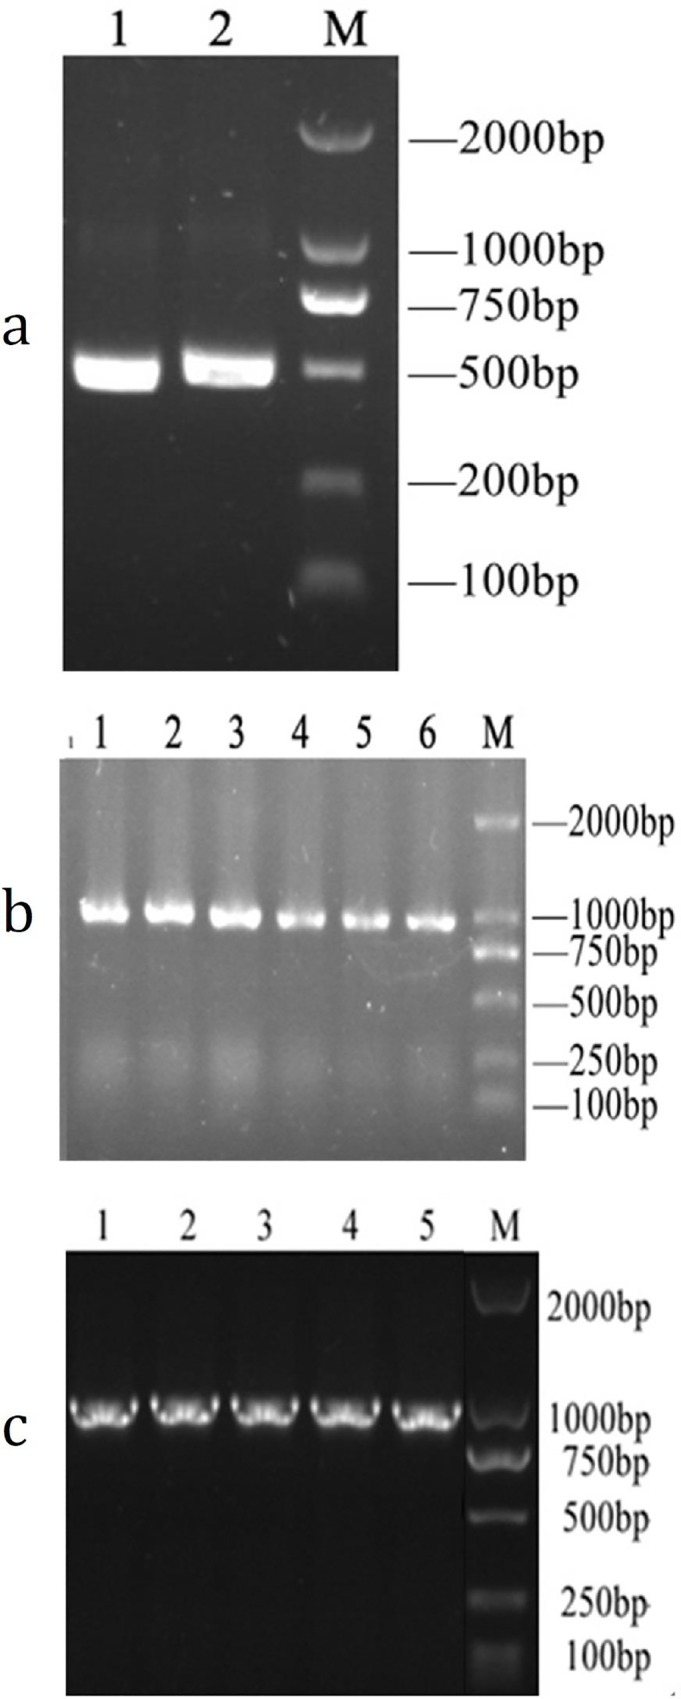
Construction of expression plasmids and transformation of P. pastoris.(a)Amplification of pIFN-γ gene with high fidelity PCR after optimization. M 3452 wide-type protein standard molecular weight marker, Lane 1–2 for optimized pIFN-γ1 gene. (b) Transformation of pIFN-γ1 and pIFN-γ1-His tag in P. pastoris. M 3452 wide-type protein standard molecular weight marker, Lane1-3 for pPICZαA- pIFN-γ1-His tag, Lane 4–6 for pPICZαA- pIFN-γ1. (c) Transformation of pPICZαA-pIFN-γ1’and pPICZαA-pIFN-γ1’-His tag in Pichia pastoris. M for DL2000 marker, Lane 1–2 for pPICZαA- pIFN-γ1’-His tag, Lane 3–5 for pPICZαA- pIFN-γ1’. (pIFN-γ1: a modified porcine gamma by yeastcodon preference; pIFN-γ1-His tag:a modified porcine gamma (pIFN-γ1)with adding histidine label; pIFN-γ1’:a modified pIFN-γ (pIFN-γ1)with C-terminal amino acid mutation; pIFN-γ1’-His tag:a modified pIFN-γ (pIFN-γ1)with C-terminal amino acid mutation and adding histidine label).